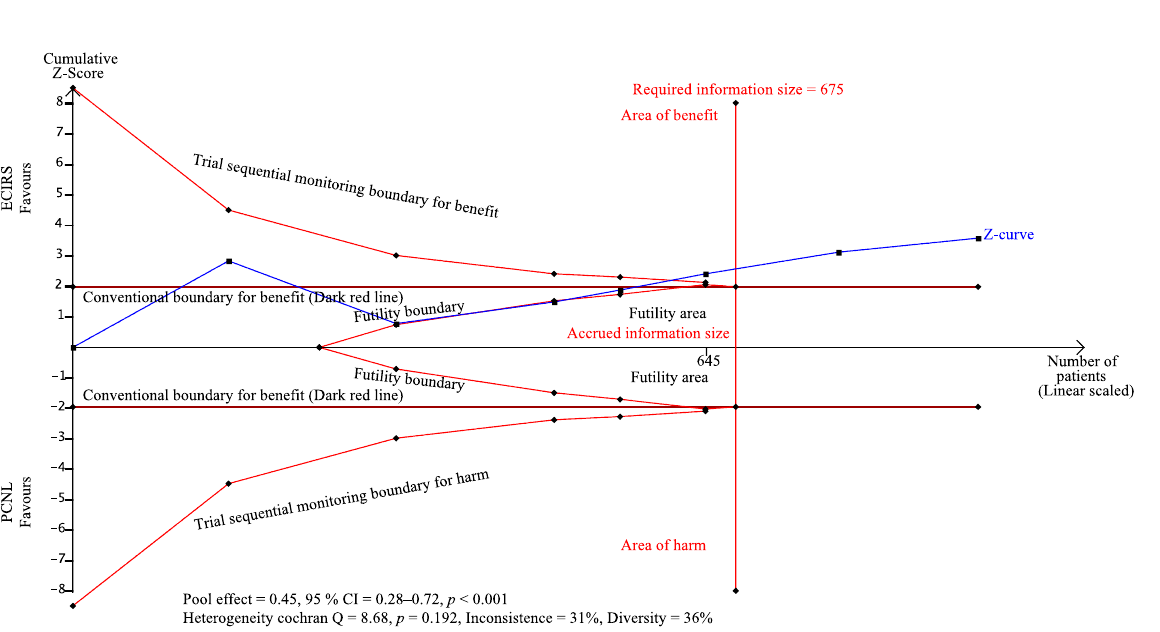
Figure A48. Trial sequential analysis of outcome regarding overall complications.